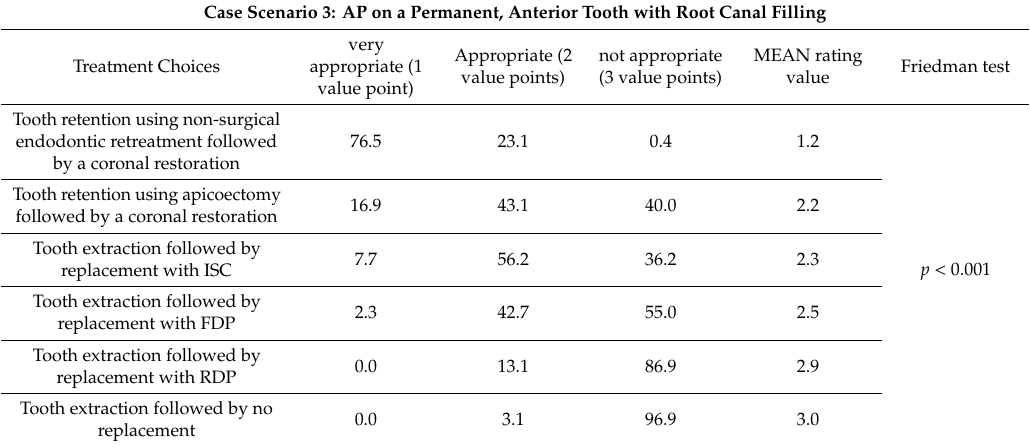
Table 5. Preferences of survey participants regarding case scenario 3 in %, mean rating value and results of the Friedman test comparing all treatment choices.